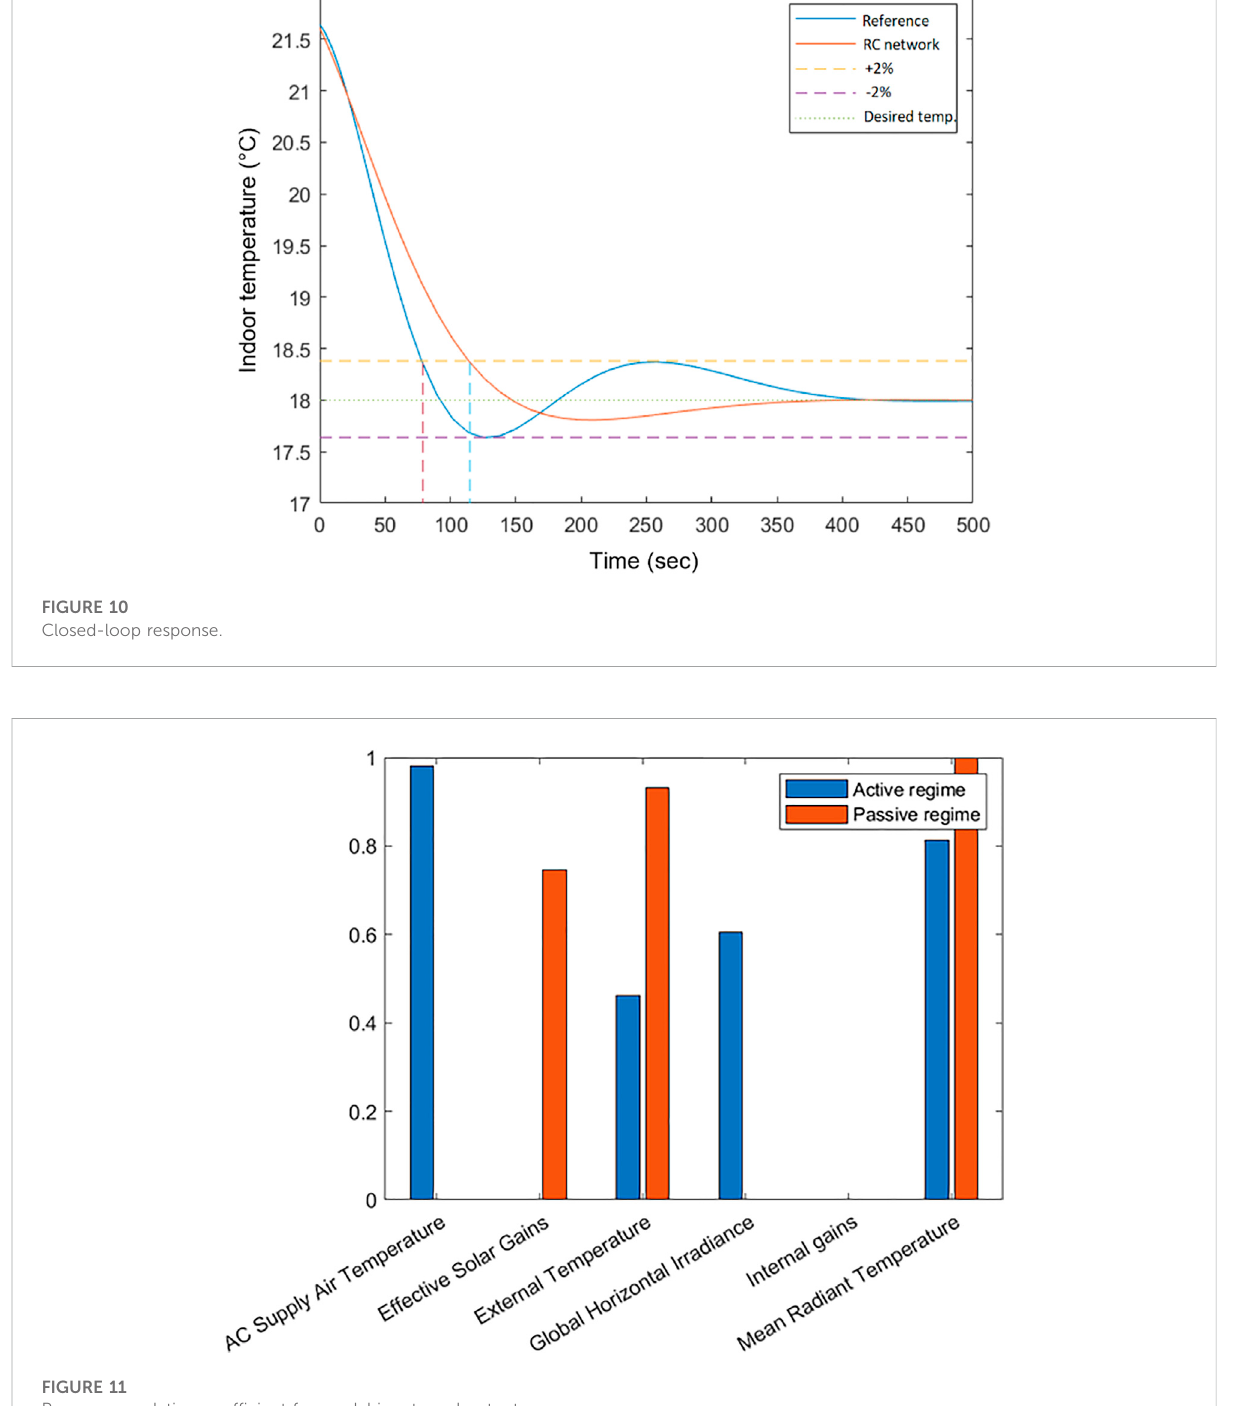
highly correlated with the output, indicating good estimators. However, the mean radiant temperature is a better estimator, having a higher correlation index. Since this temperature